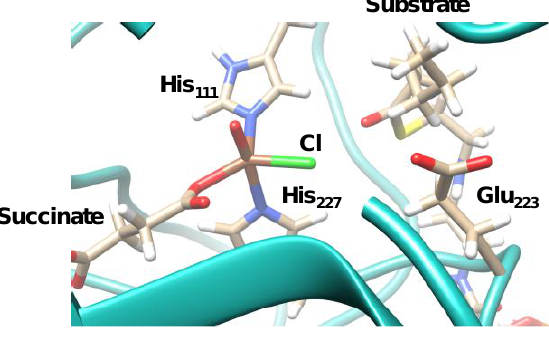
Figure 12. QM/MM-optimized geometry (B3LYP/SV(P):Charmm) of the iron(IV)-oxo(chloride) reactant complex. Key amino acids and functional groups highlighted.